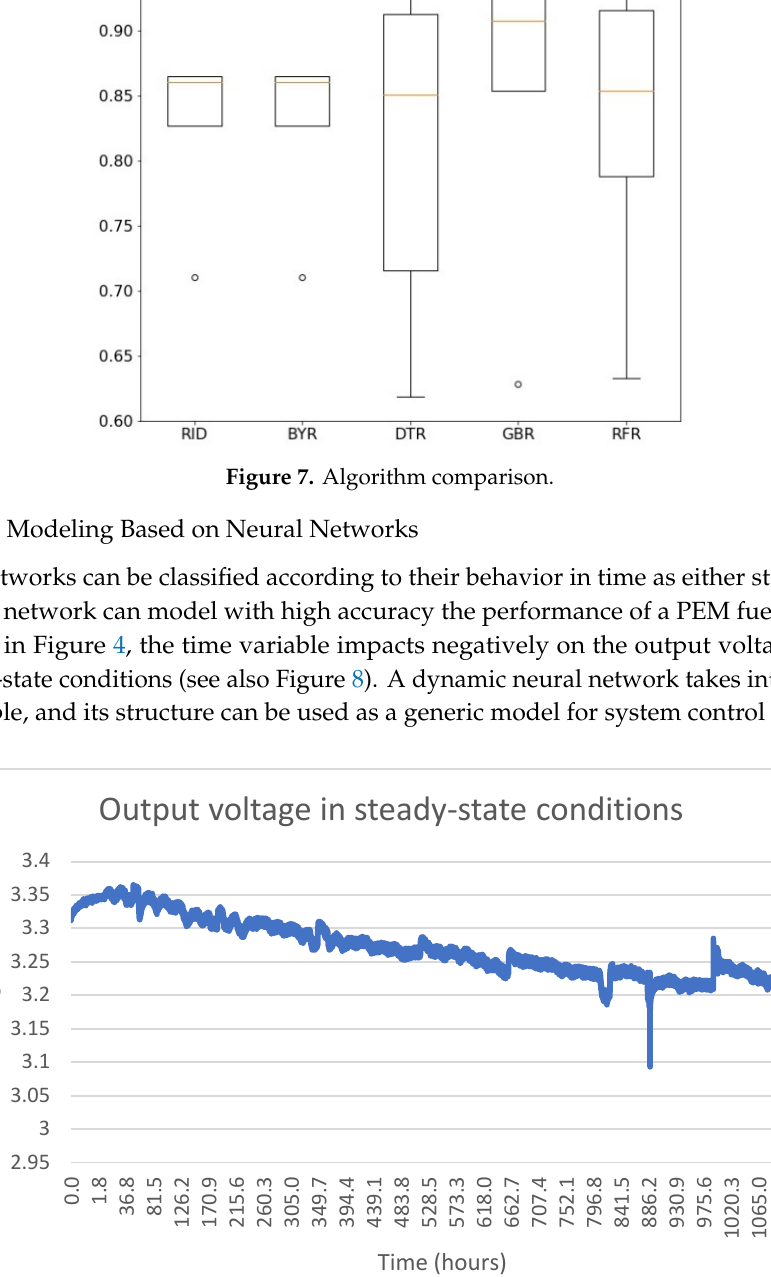
Figure 9. Dynamic neural network structure. The high regression accuracy (R 2 = 0.96) and the fast convergence are mainly due to the fact that in the PCA analysis, the irrelevant and redundant variables which have no impact on the output voltage were eliminated. The eliminated variables do not have value for control purposes. In Table 4 are presented the scores of each fold. In Figure 10, a comparison of the actual values against the predicted values is presented.